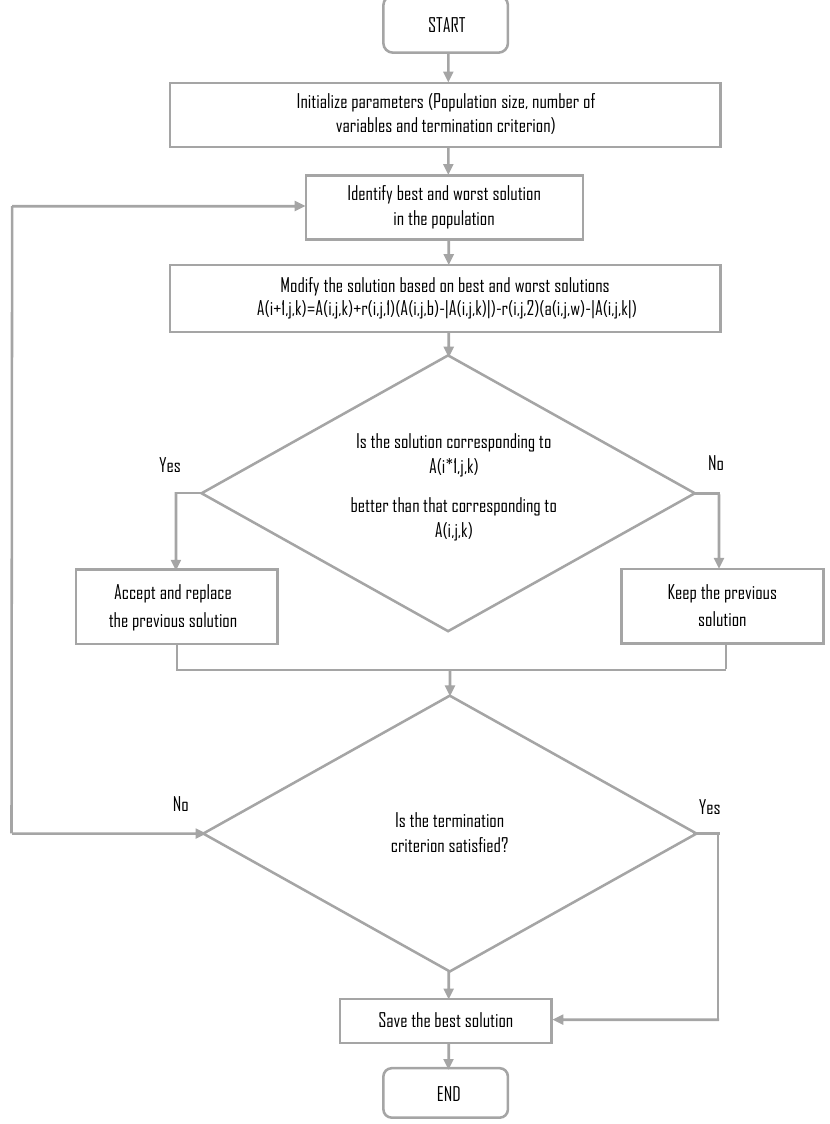
Figure 4. The original Jaya algorithm flow